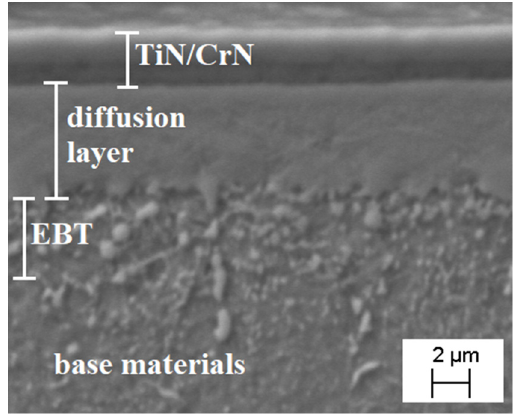
Figure 9. Cross-sectional SEM images of W320 tool steel after electron-beam treatment, plasma nitriding and a deposition of a bilayer TiN / CrN coating [43]. (Reproduced with permission from ref. [43]. Copyright (2017), Bulgarian Academy of Sciences: Union of Chemists in Bulgaria).